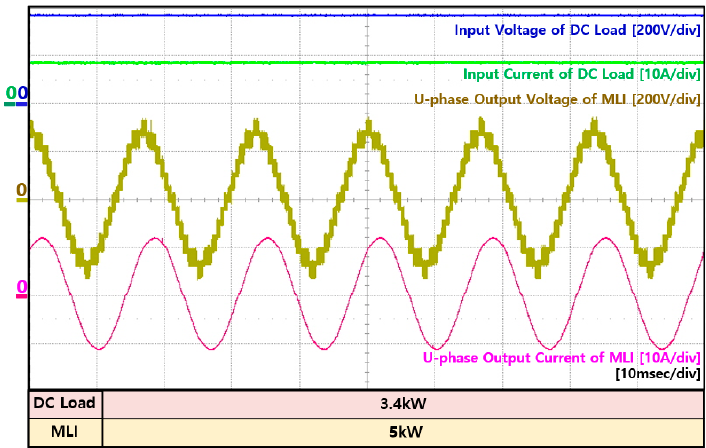
Figure 20. Experiment waveforms of DC load and multi-level inverter in mode 3.